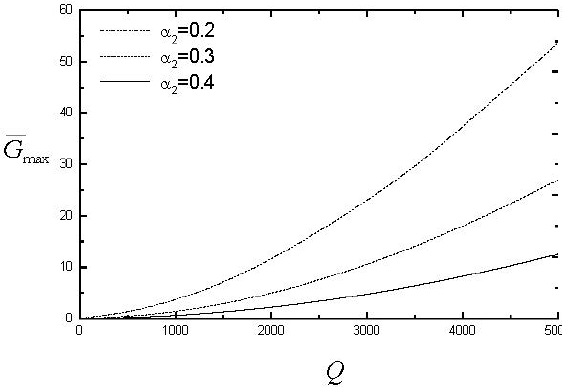
Figure 9. Effect of delamination depth on maximum of energy re- lease rate